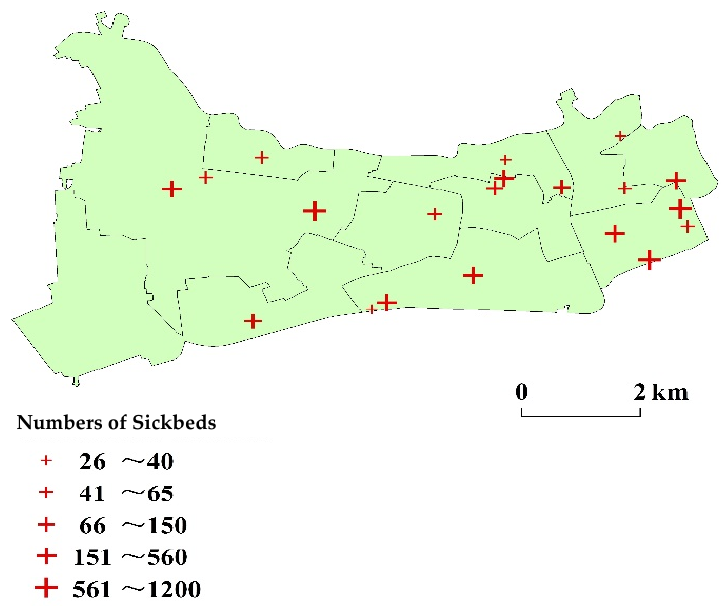
Figure 5. Distribution of medical facilities in Changning District.